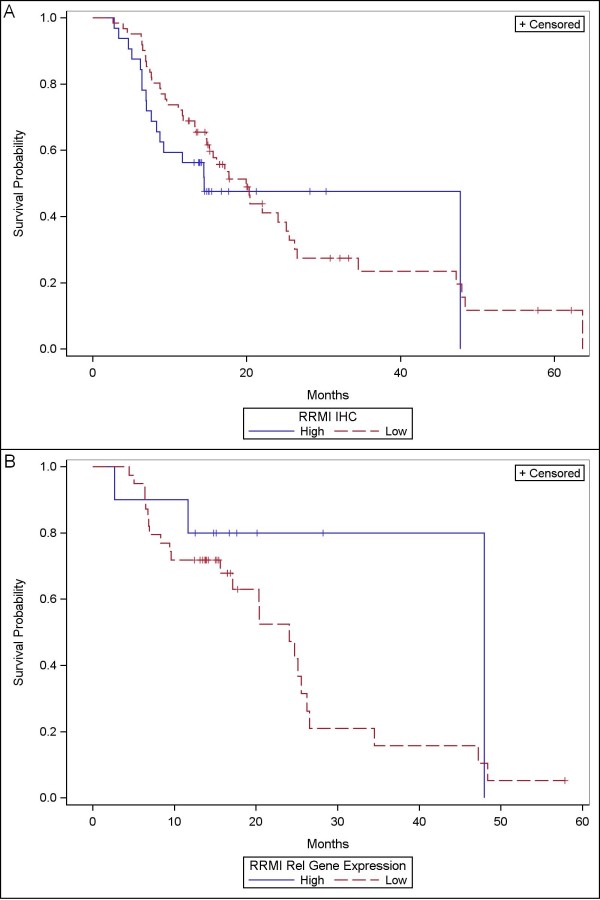
Kaplan Meier curve for overall survival according RRM1 expression by: A) - IHC (P = 0.5) and B) - PCR (P = 0.21).